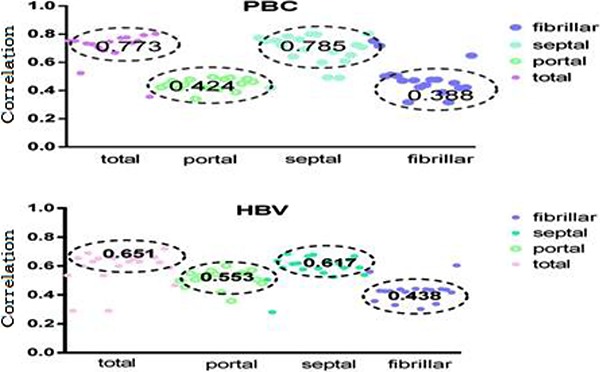
Correlation of parameters and stages of liver fibrosis in samples from chronic hepatitis B (CHB) and primary biliary cirrhosis (PBC).